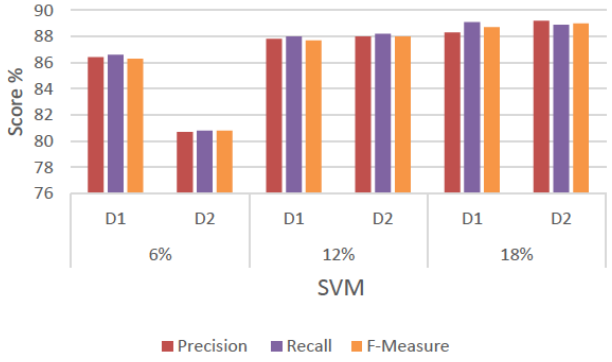
Figure 8: Sentiment prediction using IG and SVM with different k